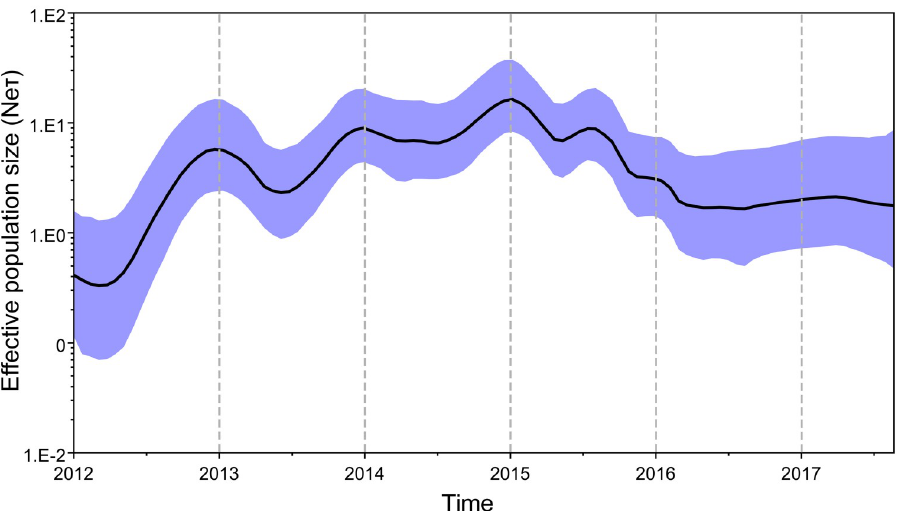
Fig 5. Bayesian skyride analysis of Cambodian clade 2.3.2.1c AIV genetic diversity. Genetic diversity was estimated using the Gaussian Markov Random Field (GMRF) model using the HA BEAST dataset. The x-axis measures time in years and the y-axis is an estimate of genetic diversity calculated from Ne τ (effective population size and the generation length in years) shown in log scale. The median estimate of genetic diversity over time is shown as a solid black line and the purple shading represents the 95% HPD